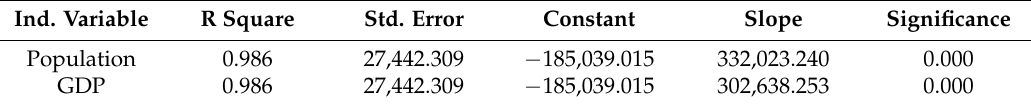
Table 4. Summary of the model with both Population and GDP as the variable. Ind. Variable R Square Std. Error Constant Slope Significance Population 0.986 27,442.309 − 185,039.015 332,023.240 0.000 GDP 0.986 27,442.309 − 185,039.015 302,638.253 0.000